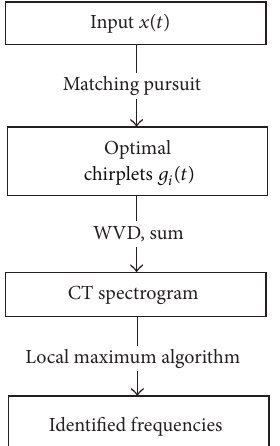
Figure 3: Identification procedure.